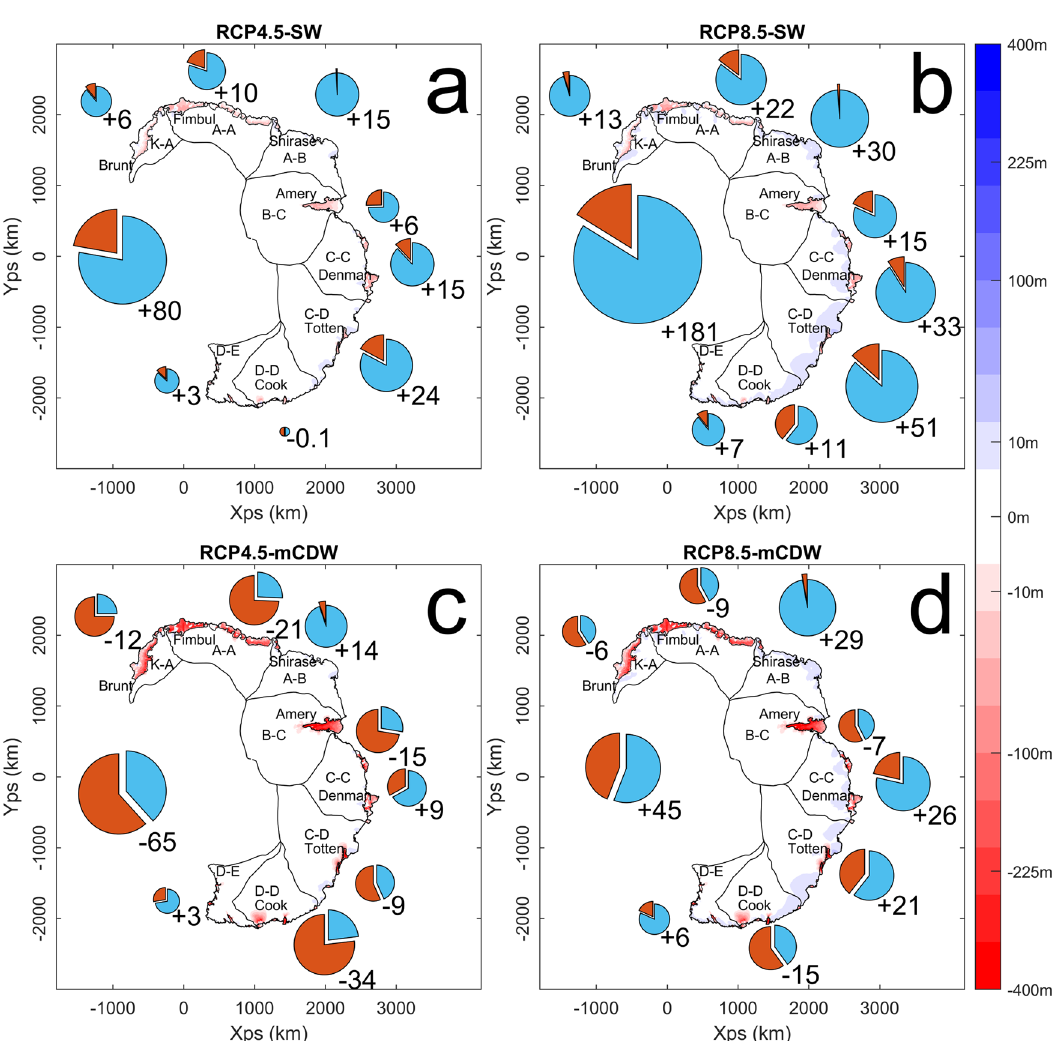
Fig. 3 | Regional mass balance of the East Antarctic Ice Sheet after 100 years. Total mass balance in GTa − 1 for the eight model catchments as well as the total model domain (pie charts, with area proportional to the net mass balance and the relative contribution of ice discharge in red and surface precipitation in blue) and